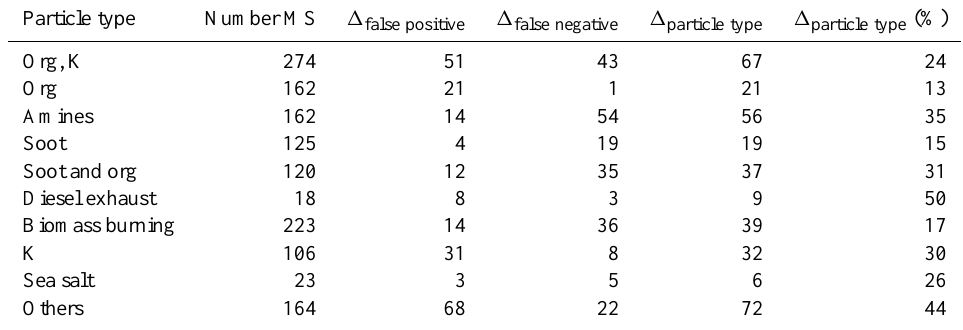
Table 2. Overview of particle types and the corresponding determined uncertainties of the clustering by the fuzzy c -means algorithm. The particle types “mineral dust” and “Ca” were not included in the reduced test data set.